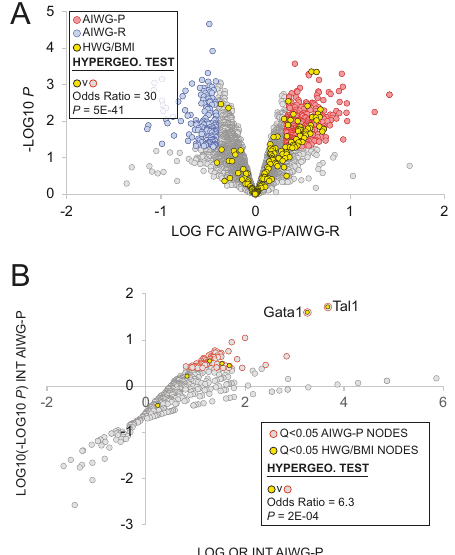
Fig. 7 Conservation of immunomodulatory pathways supporting AIWG in mice and weight gain and elevated body mass index in humans. A . Volcano plot of differential gene expression between AIWG-P and AIWG-resistant mice. The AIWG-P gene set (AIWG-P/ AIWG-R FC > 1.25, p < 0.05) is indicated in red and the AIWG-R gene set (AIWG-P/AIWG-R FC < 0.75, p < 0.05) is indicated in blue. p > 0.05 genes are colored gray. A hypergeometric test was performed on the overrepresentation in the AIWG-P gene set of mouse orthologs of the human HWG/BMI gene set, indicated in yellow. Refer to the Supplementary fi le for the speci fi c intersecting genes (section 2, Mm HWG/BMI column) and the full human HWG/ BMI gene set (section 8). Box acronyms: INT, intersection; OR, odds ratio; p, p -value of hypergeometric test. B In total, 699 pathway nodes included in the AIWG-P HCT intersection analysis (Supple- mentary fi le section 4) were plotted as log odds ratio (log OR) against log10(-log10 P). A double-log procedure was required due to the large p -value range. Nodes with signi fi cant ( q < 0.05) HCT intersections with the AIWG-P gene set are colored gray with an orange border. Nodes with nonsigni fi cant ( q > 0.05) intersections with the AIWG-P gene set are colored gray. A hypergeometric test was performed on the overrepresentation in the q < 0.05 nodes of mouse orthologs of nodes with signi fi cant ( q < 0.05) HCT inter- sections with the human HWG/BMI gene set, indicated in yellow. Refer to the Supplementary fi le for the speci fi c intersecting nodes (section 4), the full HWG/BMI gene set (section 8), and the full results of the human HCT intersection analysis of the HWG/BMI gene set (section 9). Box acronyms: INT, intersection; OR, odds ratio; p, p -value of hypergeometric test.